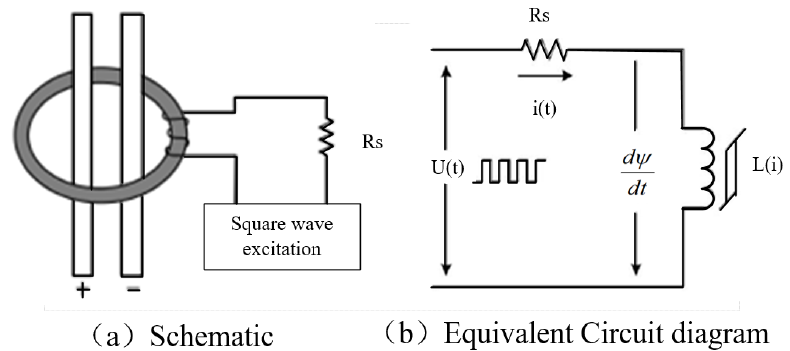
Figure 5. Schematic diagram and equivalent circuit of fluxgate DC leakage current sensor.